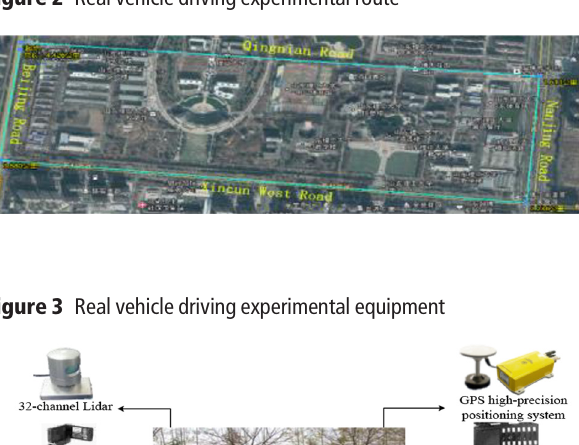
Figure 2 Real vehicle driving experimental route